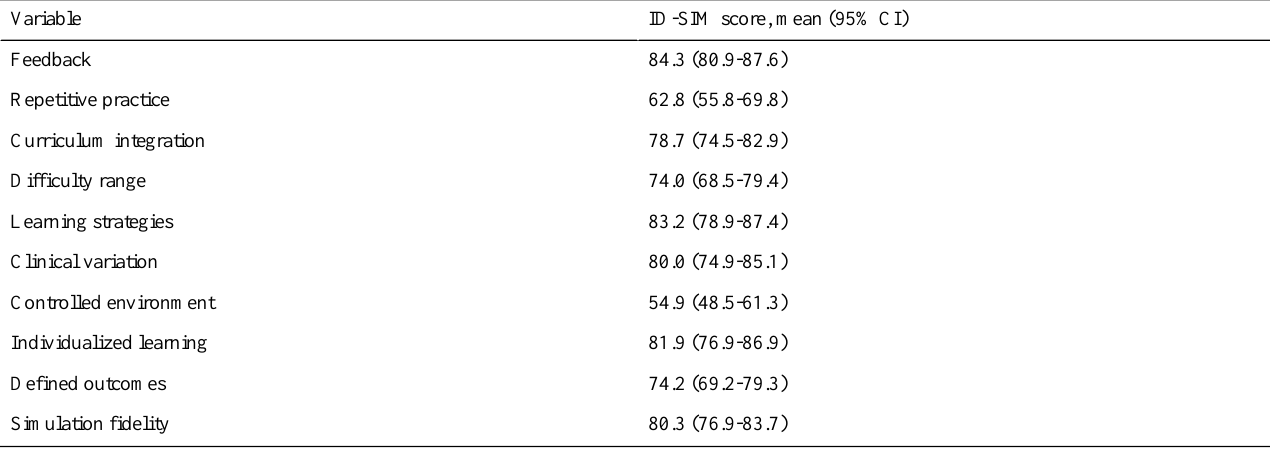
Table 1. Mean scores of senior house officers on the